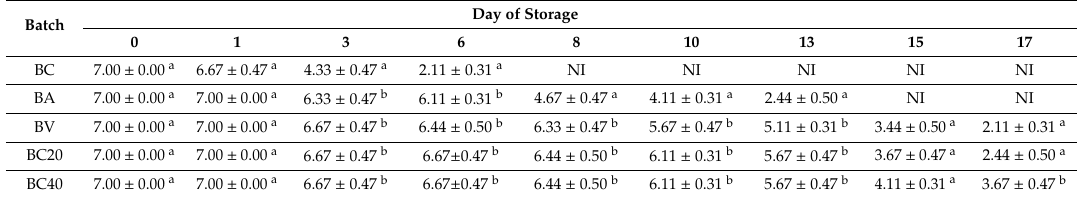
Table 6. Overall appearance of chicken legs treated with 2% lactic acid and packaged under di ff erent